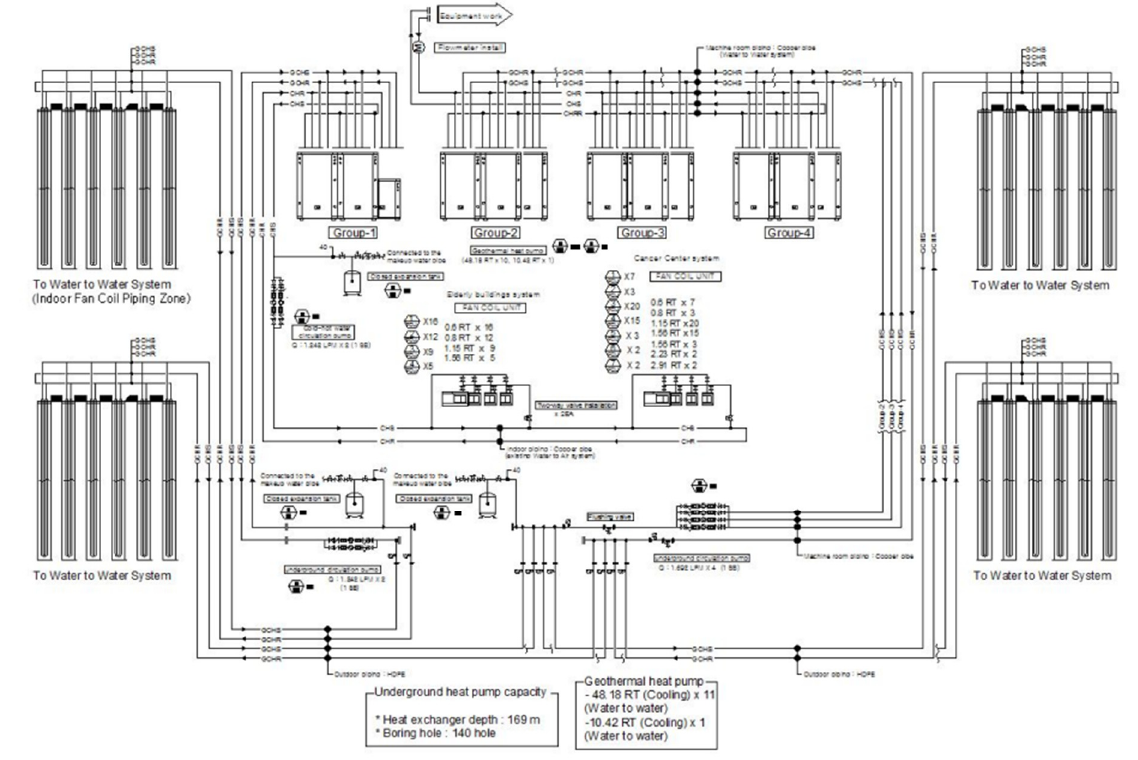
Figure 3. Schematic diagram of the GHP